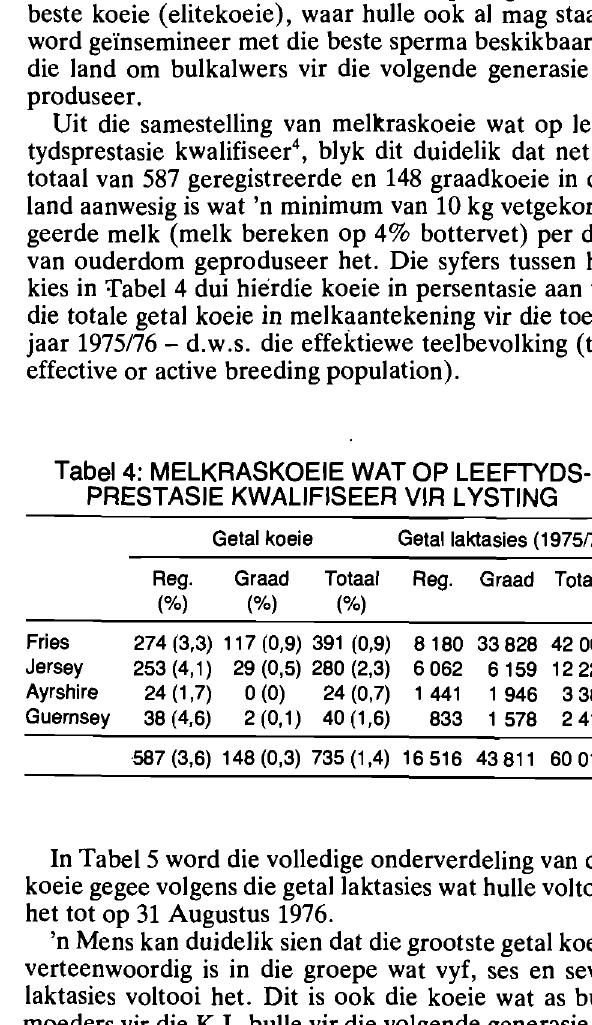
Tabel3: SKATTING VAN GENETIESE VERBETERING OEUR SUPEROVULASIE EN EMBRIO-OORPLASING